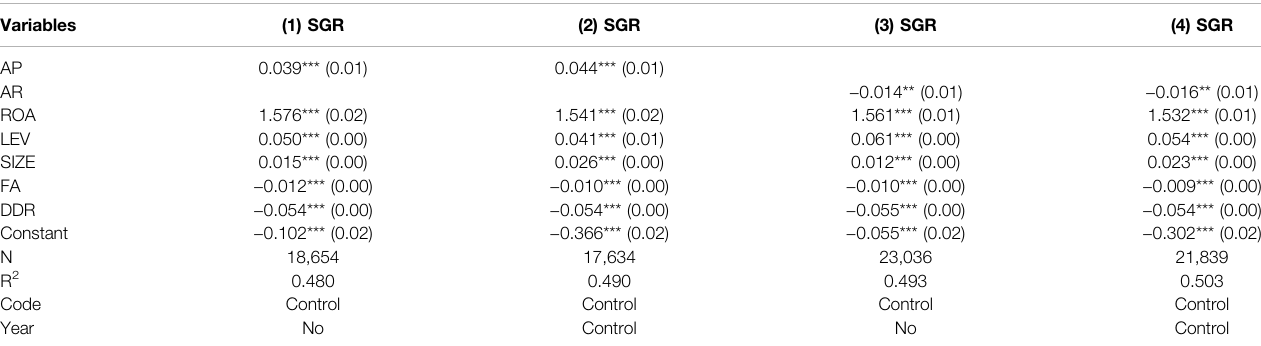
TABLE 4 | Benchmark regression results: Trade credit and sustainable growth.